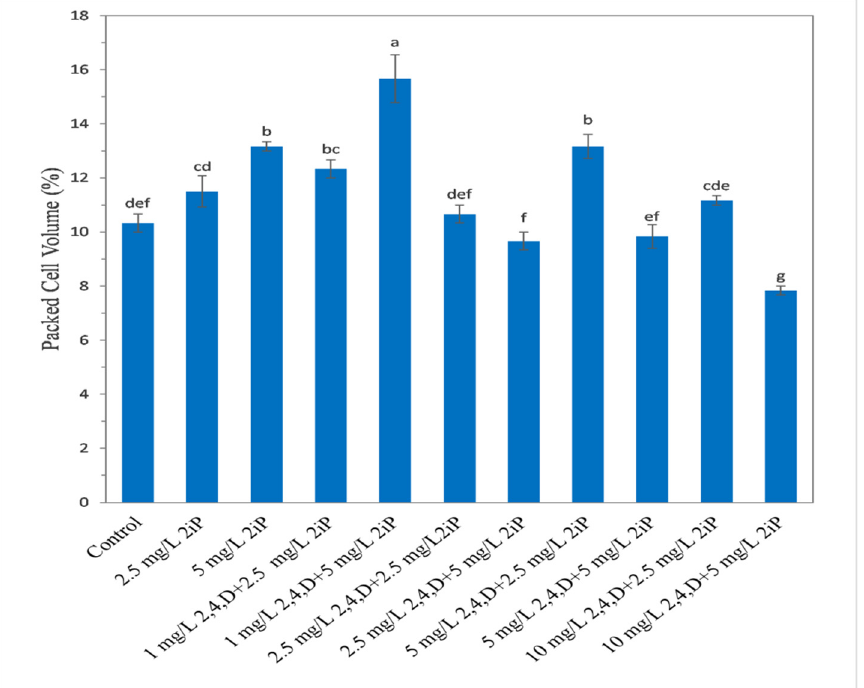
Figure 2. Effect of 2iP and 2,4-D on packed cell volume (%) in date palm cell suspension culture. At the eleventh week of culture, data were recorded. Line bar represents the standard error (SE). The same letters indicate no significant difference according to DMRT at p ≤ 0.05.